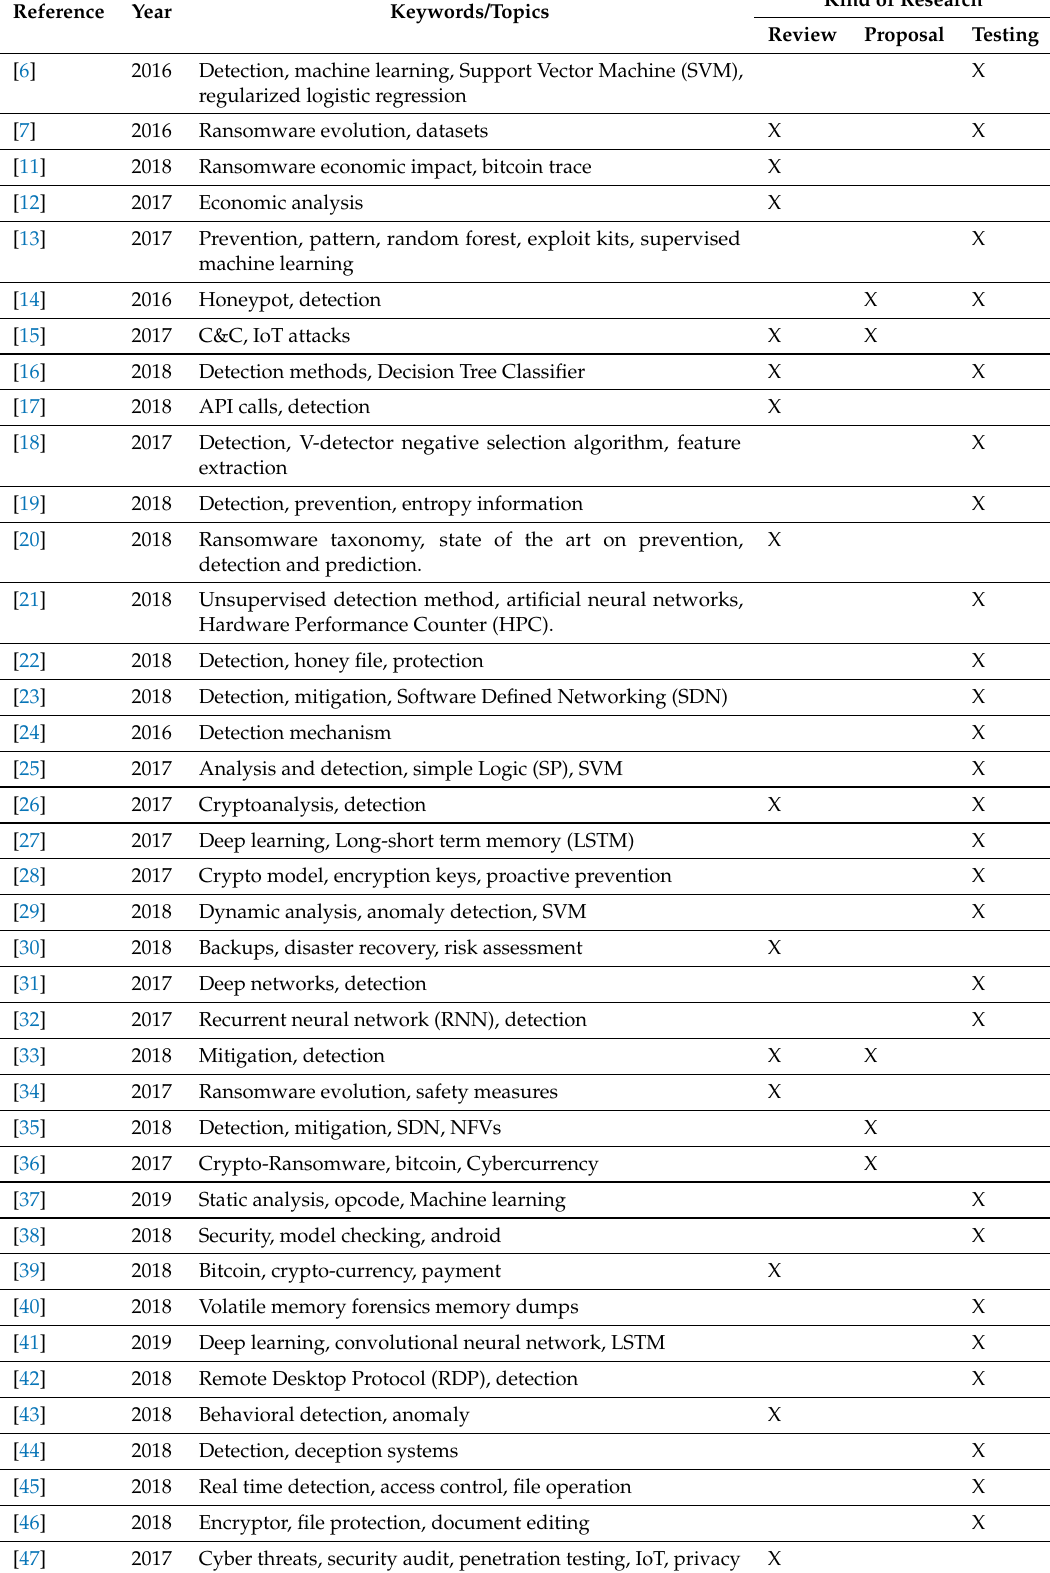
Table 1. Summary of current